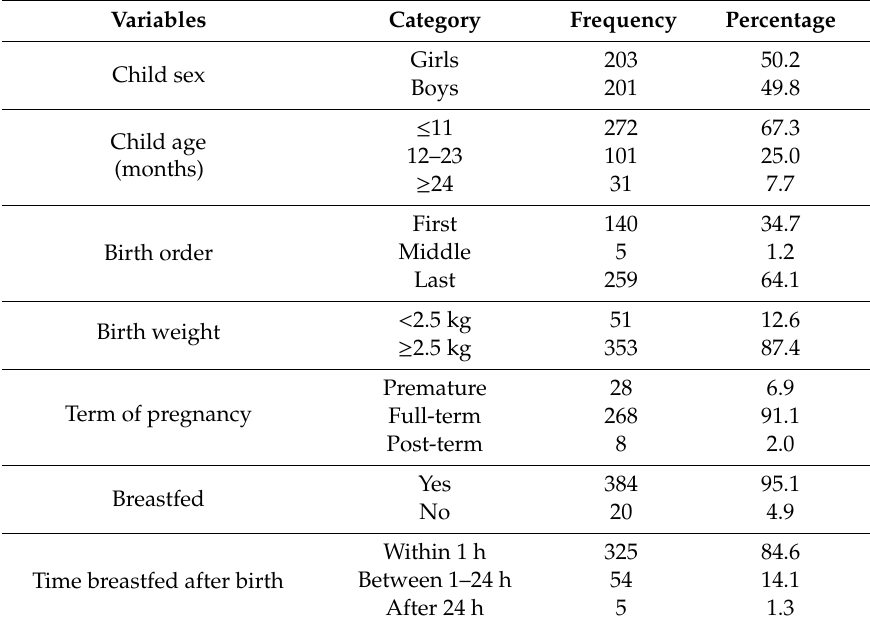
Table 1. Characteristics and caring practices of children under five years of age ( n =